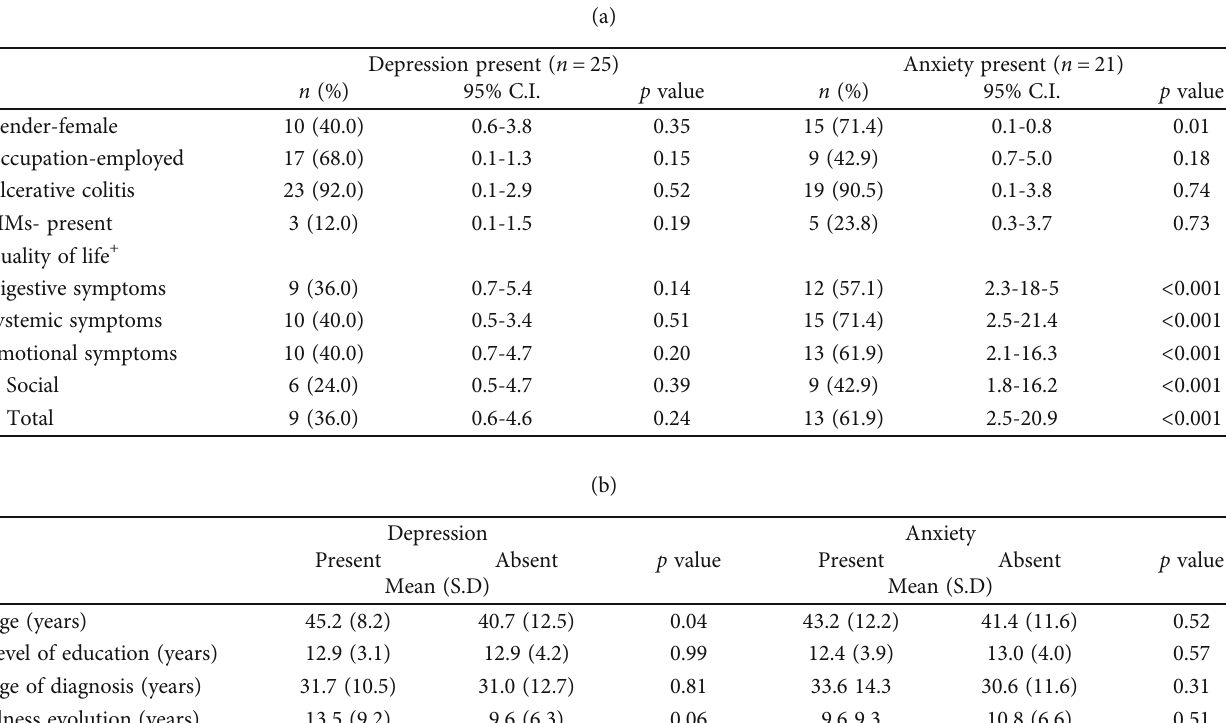
Table 1: Demographic and clinical features between IBD patients with and without depression or anxiety